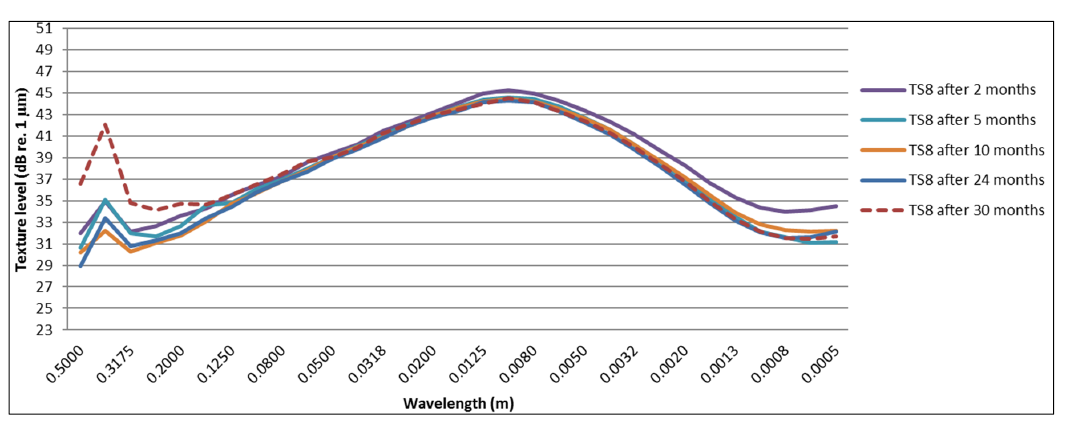
Figure 19. Change in texture spectra over a period of 30 months for Test Section 8 (25 ‐ mm thickness).